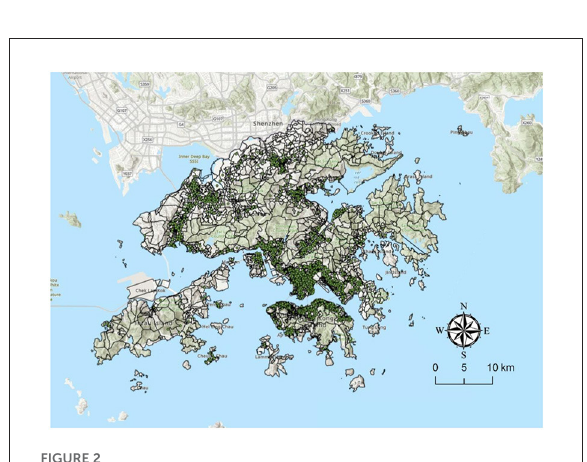
FIGURE2 The spatial distribution of the sampled older